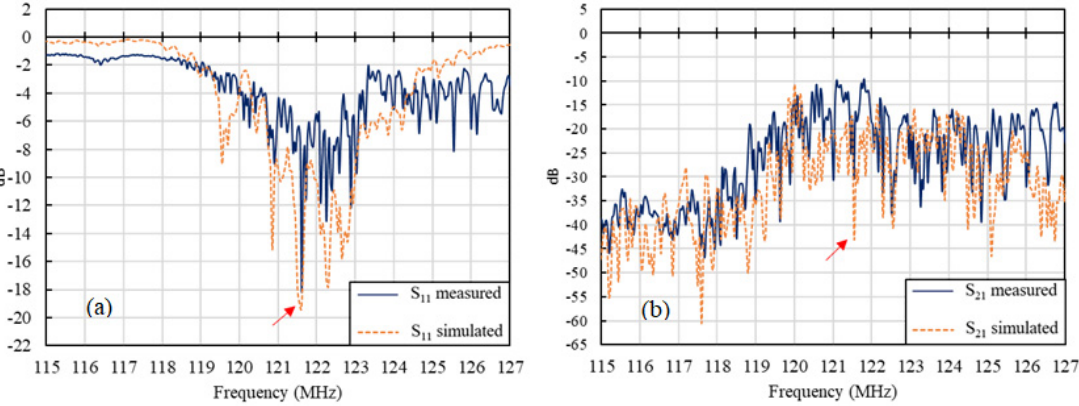
Figure 4. Comparison of ( a ) S11 and ( b ) S21 between simulated and measured frequency responses in the range of major resonance frequencies. Arrows indicate the location of center frequency.